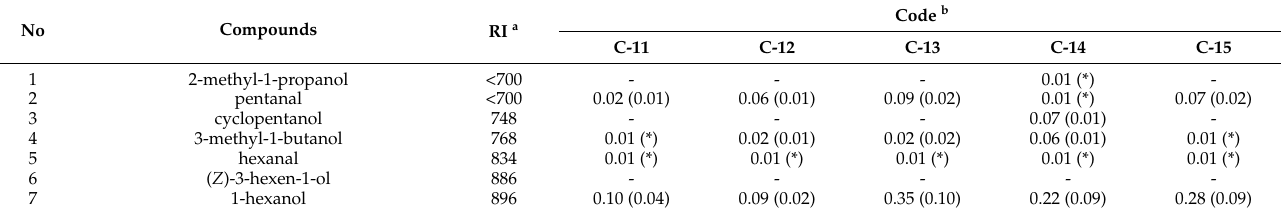
Table 4. Volatile compounds detected in the samples